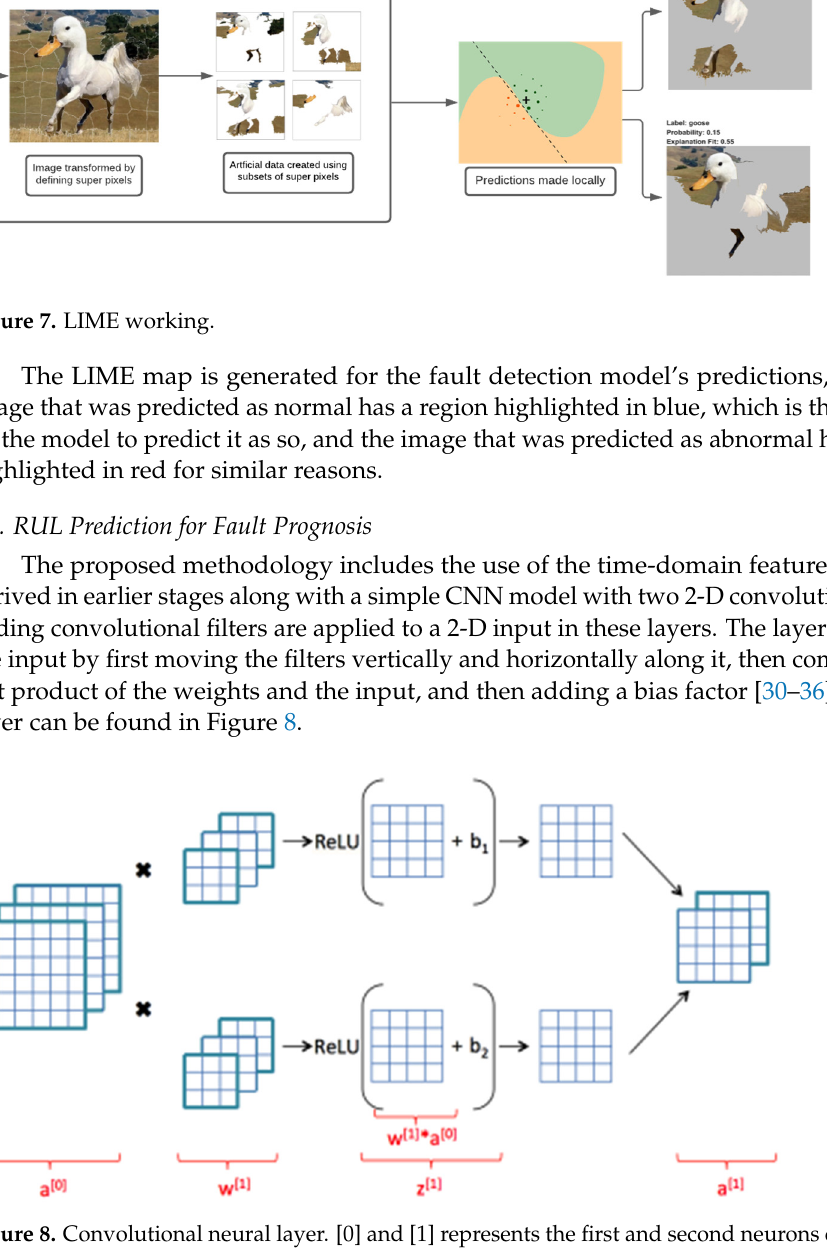
Figure 8. Convolutional neural layer. [0] and [1] represents the first and second neurons of the layer, * represents multiplication and x shows the conversion of the image into smaller parts in the next